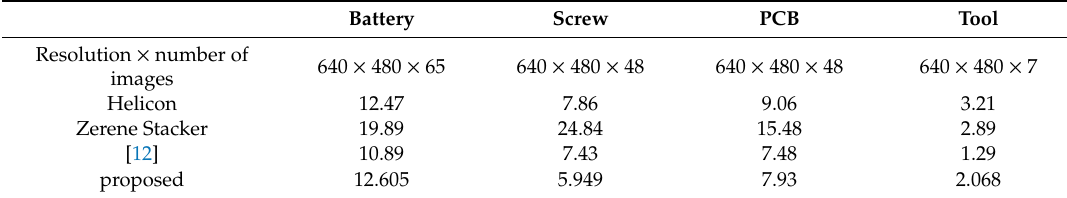
Table 2. Comparison of computing time